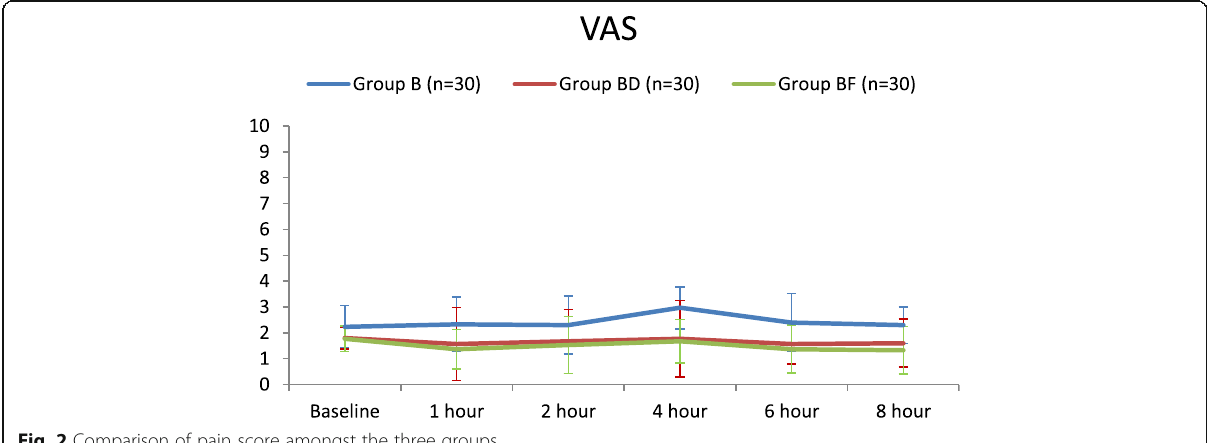
Fig. 2 Comparison of pain score amongst the three